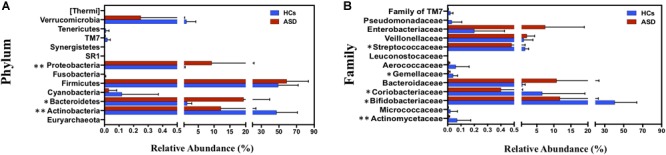
Taxonomic differences of gut microbiota between HCs and ASD groups. (A) Percentage distribution of all bacterial phyla identified and (B) percentage distribution of significant bacterial families (p < 0.05) between HCs and ASD. ∗p < 0.05, ∗∗p < 0.01 after FDR correction. Mean values ± SD are plotted.